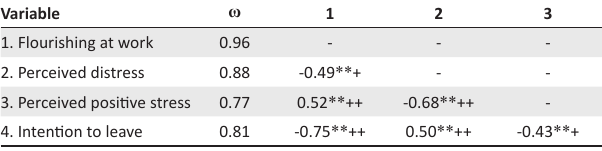
TABLE 2 : Reliability coefficients and correlations for the latent variables ( n =